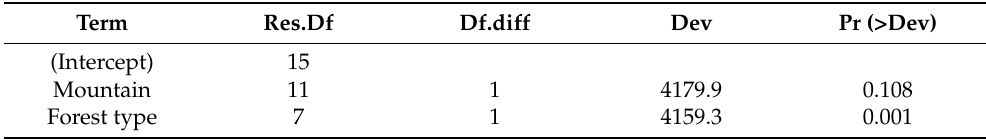
Table 2. ANOVA table from the multivariate analysis of abundance (mvabund) testing the influence of mountain and forest types across elevation. Significance level at p < 0.05.